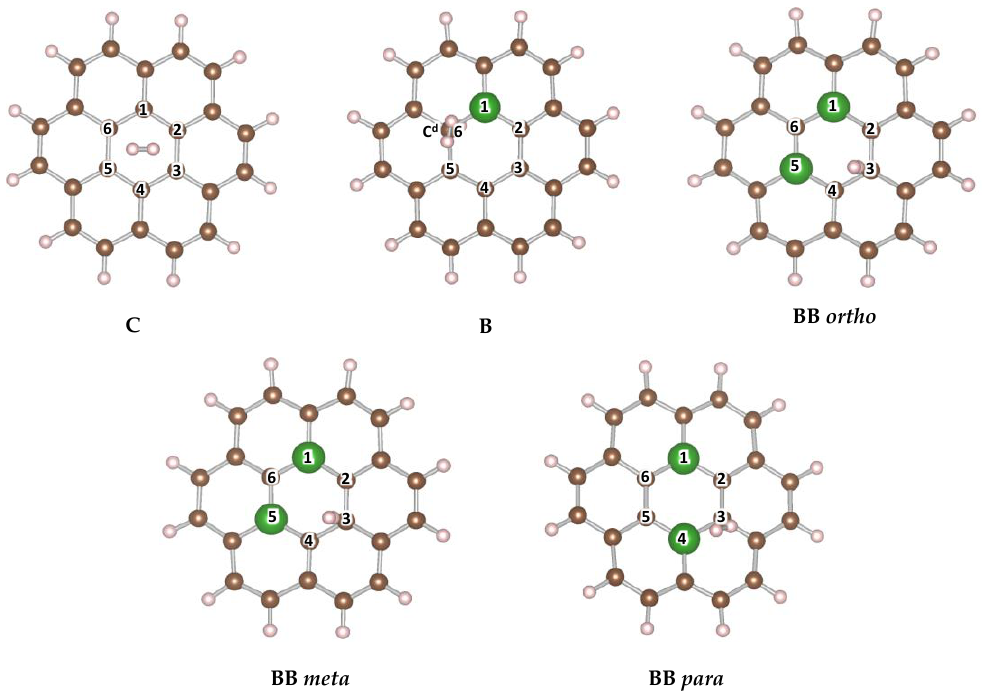
Figure 1. Coronene (C 24 H 12 ) and boron–doped coronene structural models with H 2 adsorbed. The atoms on the central ring are numbered 1 through 6 for ease of discussion in the text and in the data reported in Tables 3 and 4. For the system B, a terminal H is added on the neighboring C atom (C6) denoted as C d .